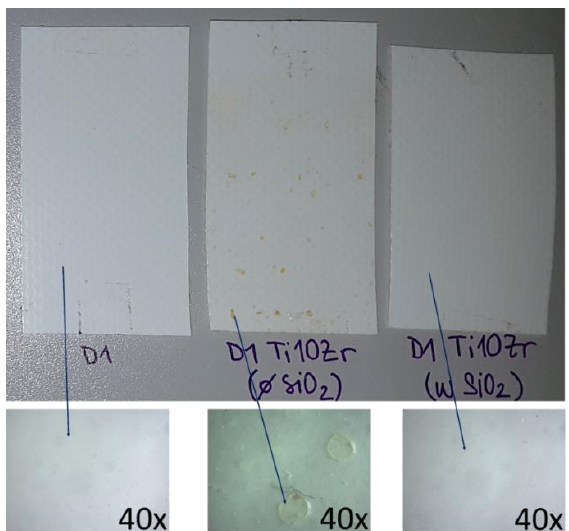
Figure 10. D1 samples exposed to ageing in Suntest chamber with a daylight filter for 14 days. Left : a neat substrate; middle : Ti10Zr film without SiO 2 binder; right : Ti10Zr with SiO 2 and their appearance under higher magnification ( below ).